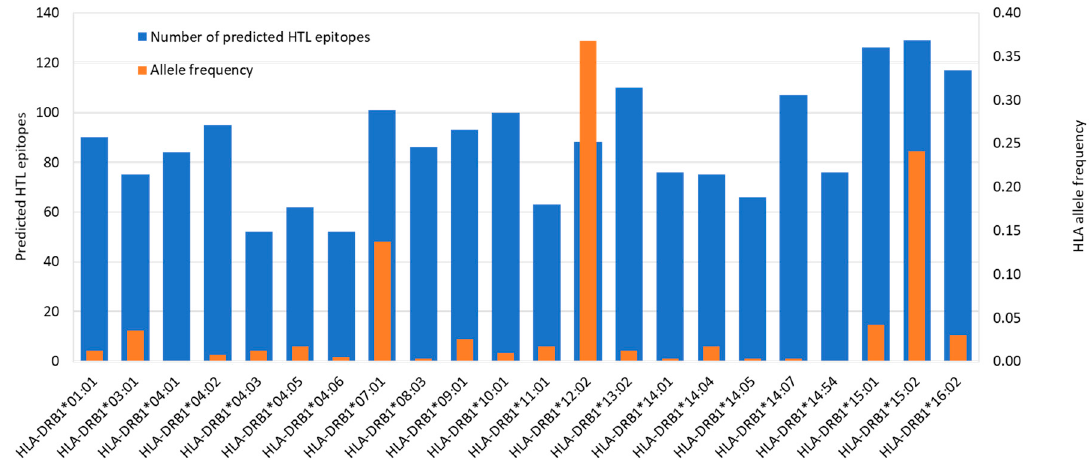
Figure 5. The number of predicted HTL epitopes that are presented by the HLA-DRB1 allele. NetHLAIIpan4.0 predicted 792 peptides bind to at least 1 HLA Class II with a strong binding affinity ( ≤ 1% percentile rank).